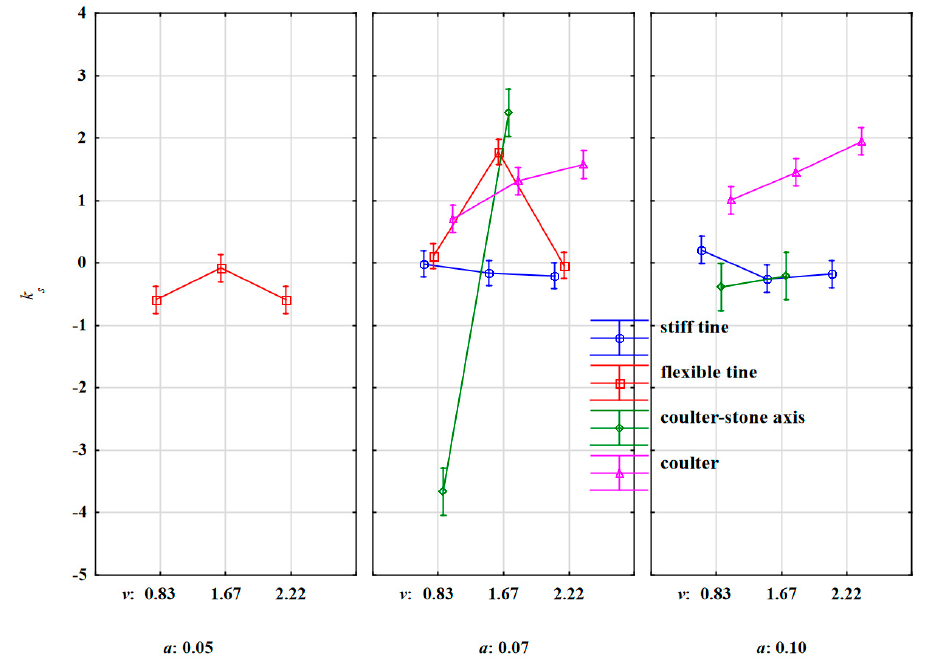
Figure 11. Slope factor of the straight line for stone movement k s discarded under the extortions of the stiff tine, flexible tine, coulter-axis stones and coulter working at varied depths and working speeds.